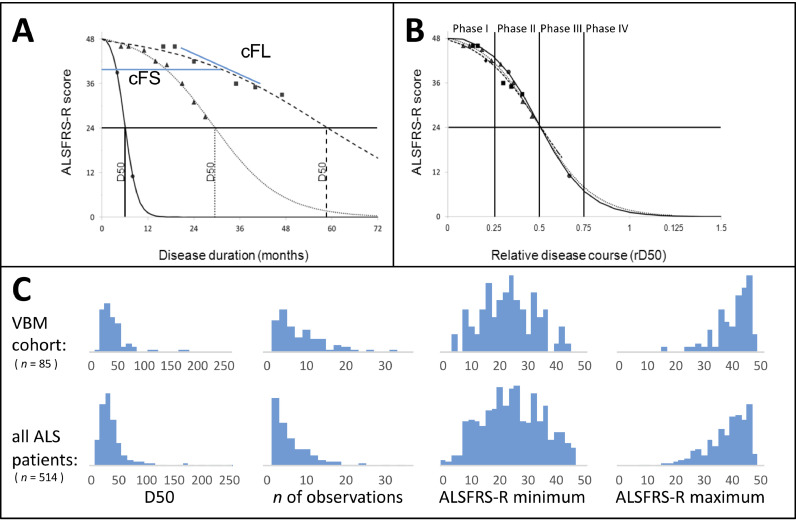
The D50 disease progression model: demonstration of principles and derived parameters.(A) Simulated disease curves of 3 ALS patients, with fast (circles), intermediate (triangles) and slow (squares) progression. Based on regularly obtained ALSFRS-R scores throughout the disease, the sigmoidal course is calculated. Resulting parameters: D50 = calculated time point when ALSFRS-R drops to 24, cFS = calculated functional state and cFL = calculated functional loss at the day of examination (for e.g. MRI acquisition). (B) Normalization with rD50, which describes individual disease course covered in reference to D50, allows for comparability between patients with vastly different disease aggressiveness and shows that patients proceed through similar Phases (I-IV) of functional decline. (C) Shows histograms of relevant variables for the current cohort of this study (top row) and all ALS patient data that is available in our center respectively. From left to right, the D50 values, number of obtained ALSFRS-R scores per patient, the minimum ALSFRS-R score and the maximum ALSFRS-R score obtained are noted; it illustrates, that the characteristics available for the VBM cohort well represent the regional ALS population.Abbreviations: ALSFRS-R: ALS Functional Rating Scale (Revised); D50: time until functionality drops to a half as estimated by the model; cFS: calculated functional state; cFL: calculated functional loss; MRI: Magnetic Resonance Imaging; rD50: relative D50.